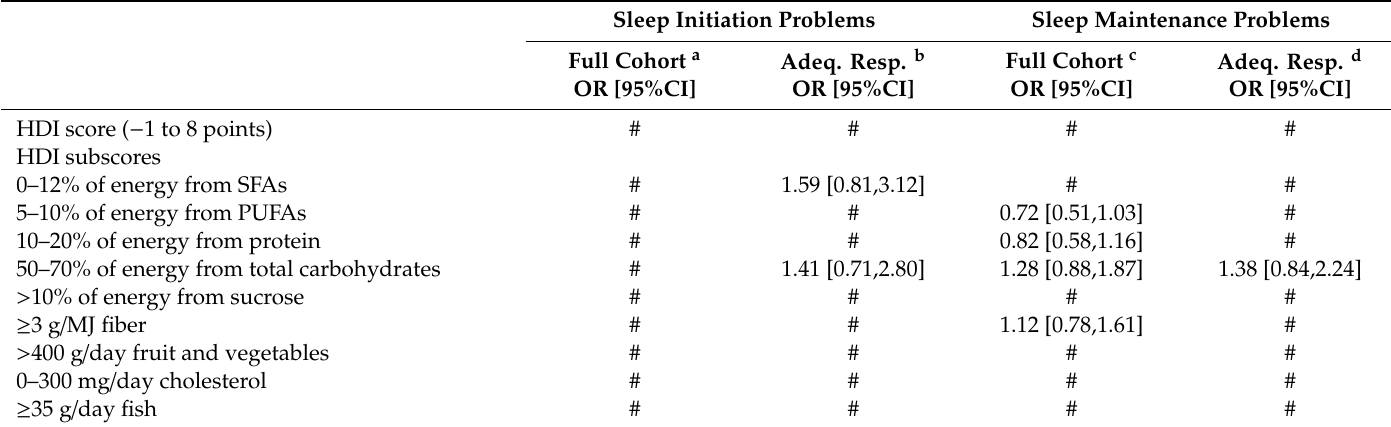
Table 3. Association between adherence to the Healthy Diet Indicator and self-reported sleep problems in older Swedish men. Sleep Initiation